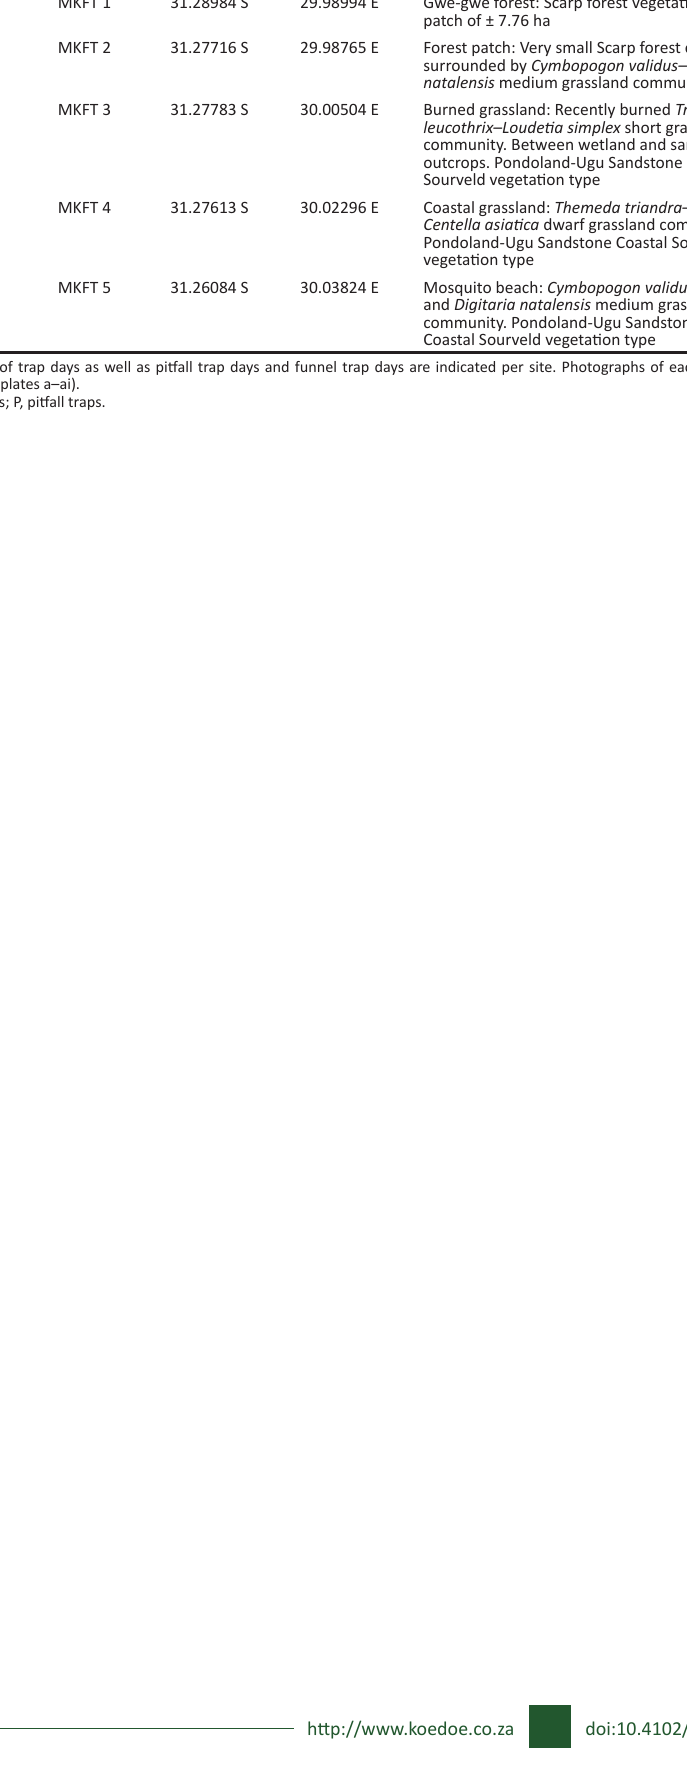
TABLE 1-A4 (Continues...): A summary of the locations, habitats and trapping dates where drift fence with pitfall or funnel combinations were set in the six protected areas along the Wild Coast, Eastern Cape, South Africa. Protected area Trap